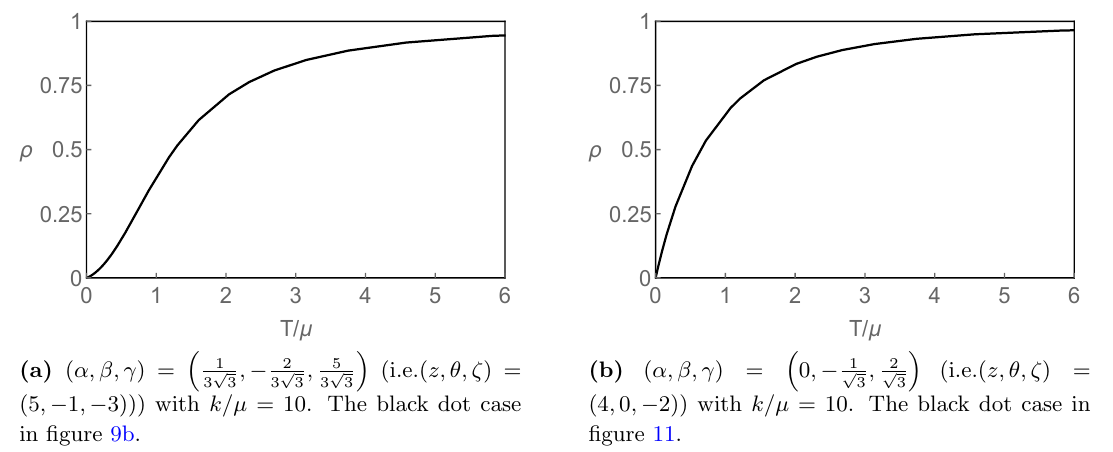
Figure 2. Resistivity vs temperature: the linear- T resistivity. ( (cid:11); (cid:12); (cid:13) ) =